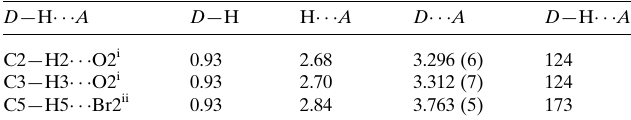
Table 1 Hydrogen-bond geometry (A˚ , (cid:2) ).